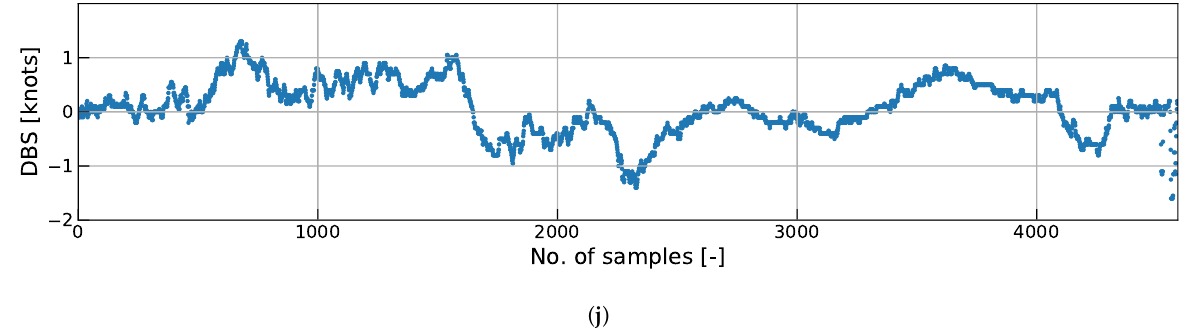
Figure 10. Ship parameters collected during a voyage from Yantian to Singapore: ( a ) RPM, ( b ) SOG, ( c ) STW, ( d ) RWS, ( e ) RWD, ( f ) RUD, ( g ) DFT, ( h ) TRM, ( i ) WSA, ( j ) DBS.